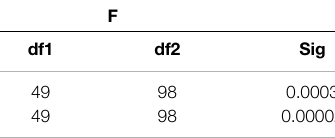
TABLE 6 | The intraclass correlation coef fi cients between TL HRV , RPE, and TRIMP. r 95% CI F Lower limit Single